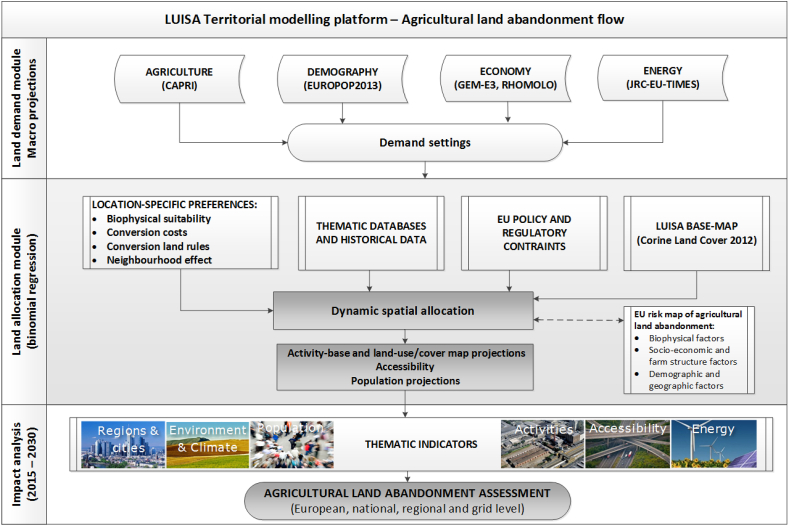
Adapted and simplified LUISA scheme to illustrate the workflow and main components for modelling, specifically, agricultural land abandonment.